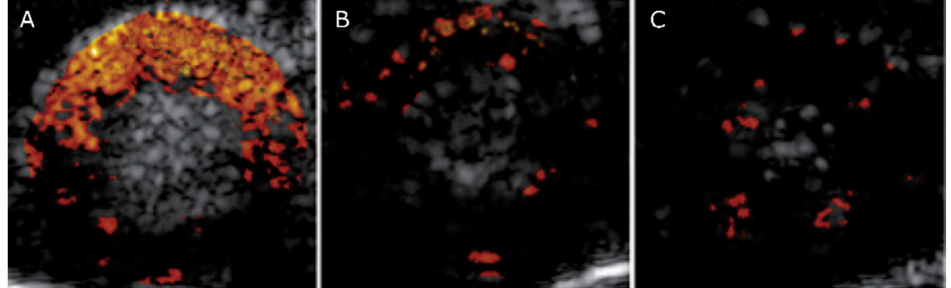
Figure 6. B-mode US images of the left ventricle 4 h after conorary occlusion overlayed with the signal of E-selectin targeted MB ( A ), non-targeted MB ( B ) and non-specific IgG targeted MB ( C ). Enhanced contrast signal is seen using E-selectin targeted MB. Reproduced with permission from [88]. Copyright SAGE Publications,